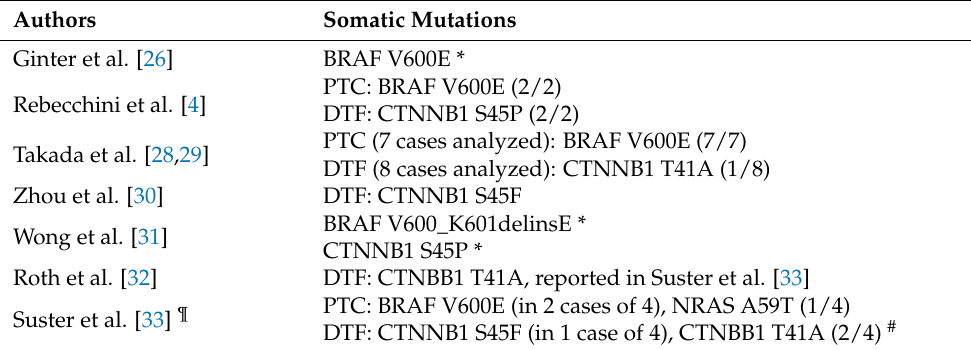
Table 2. Somatic mutations reported in